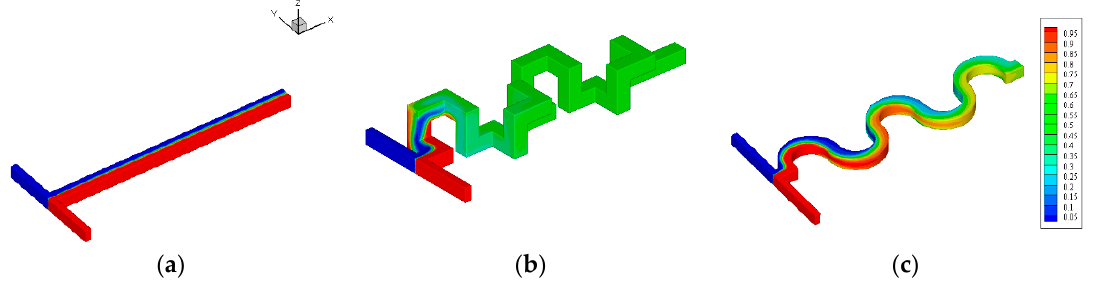
Figure 2. Mixing performance of micromixer T-junction designs. ( a ) Conventional straight; ( b ) Complex 3D serpentine; ( c ) Wavy microchannel.